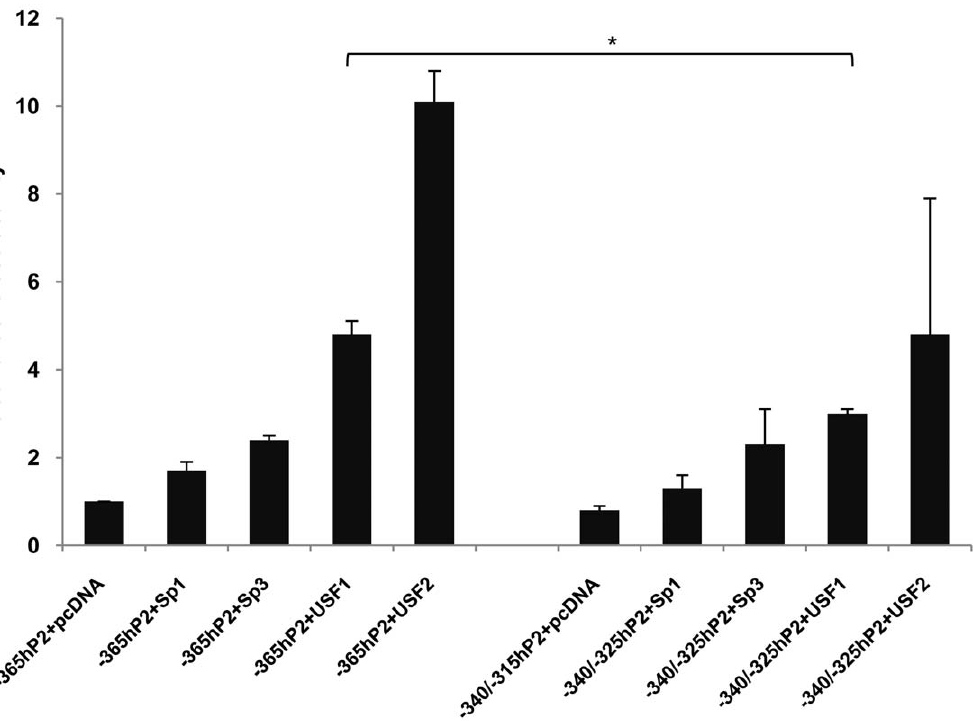
Figure 6. Transactivation of a WT 2 365 human PC P2 luciferase reporter construct and its mutant by Sp1, Sp3, USF1 or USF2. WT 2 365 hP2 or 2 340/ 2 315 hP2 constructs were co-transfected with an empty vector (pcDNA3) or a plasmid overexpressing Sp1, Sp3, USF1 or USF2 into the INS-1 832/13 cell line, and the luciferase activities measured. The luciferase activity was normalized to b -galactosidase activity and expressed as relative luciferase activity. Relative luciferase values obtained from co-transfecting cells with wild type ( 2 365 hP2) or its mutant ( 2 340/ 2 315 hP2) and plasmid overexpressing Sp1, Sp3, USF1 or USF2 were presented as fold change relative to those obtained from those co-transfected with WT with empty vector (pcDNA3) which was arbitrarily set at 1. *p #